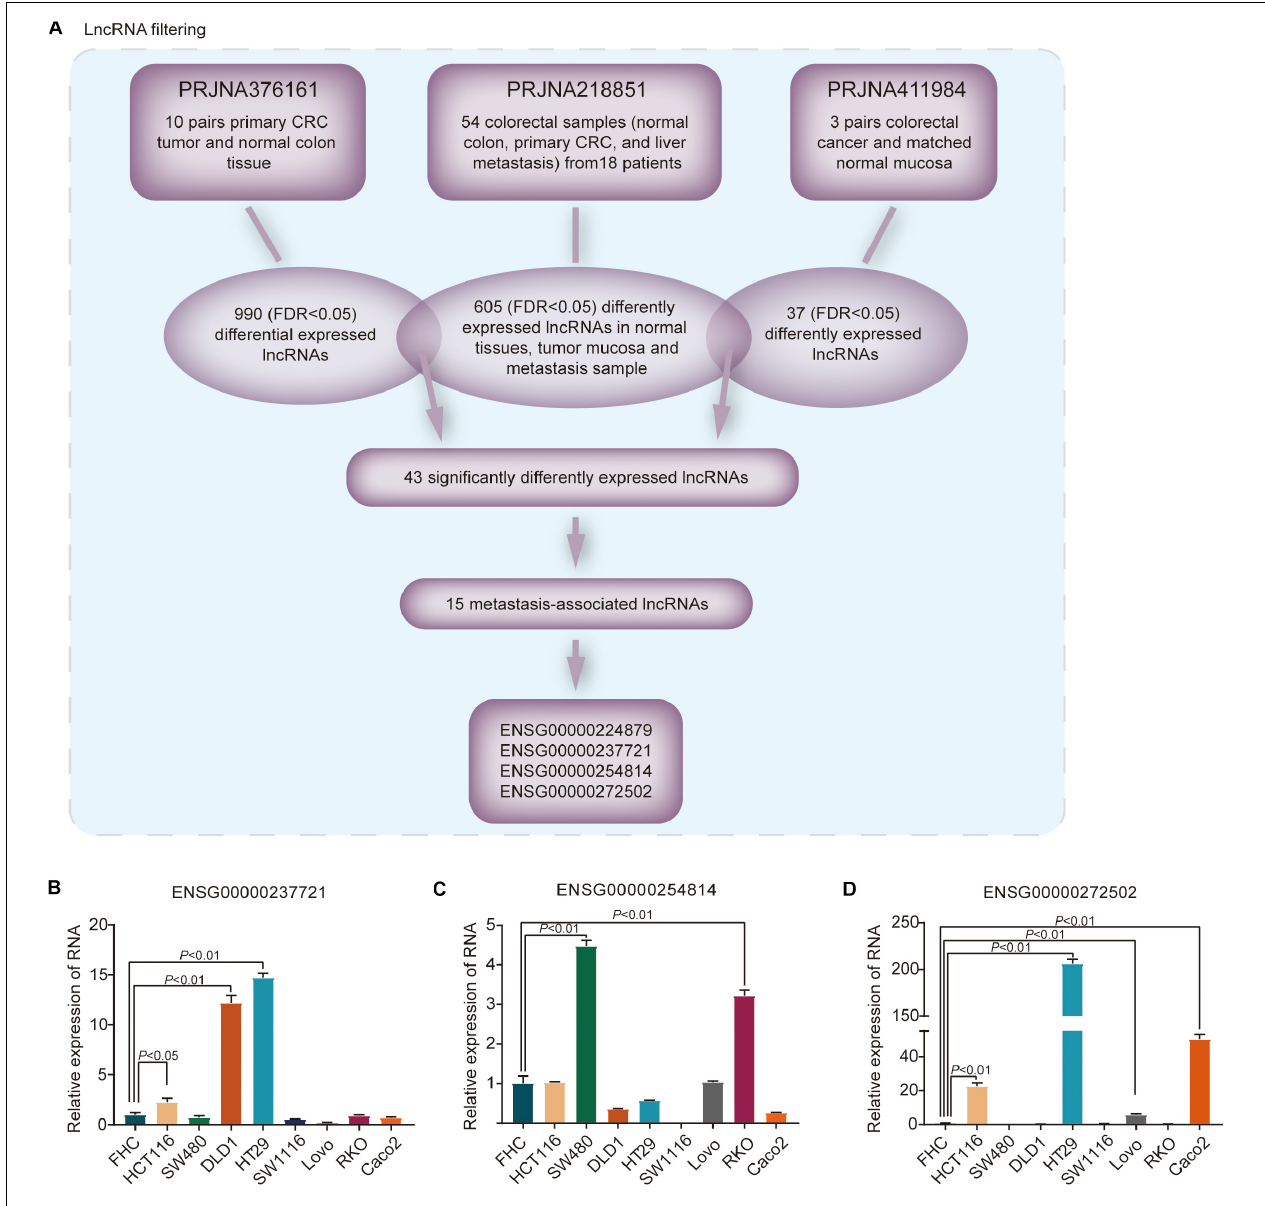
FIGURE 1 | Differential lncRNAs in metastasis-associated CRC in the SRA database. (A) Identification of the differential expression of lncRNAs in metastatic and primary CRC tissues compared with normal mucosa from the SRA patient cohort. FDR < 0.05. (B–D) The relative levels of three candidate lncRNAs were measured in normal colon epithelial cells and eight CRC cell